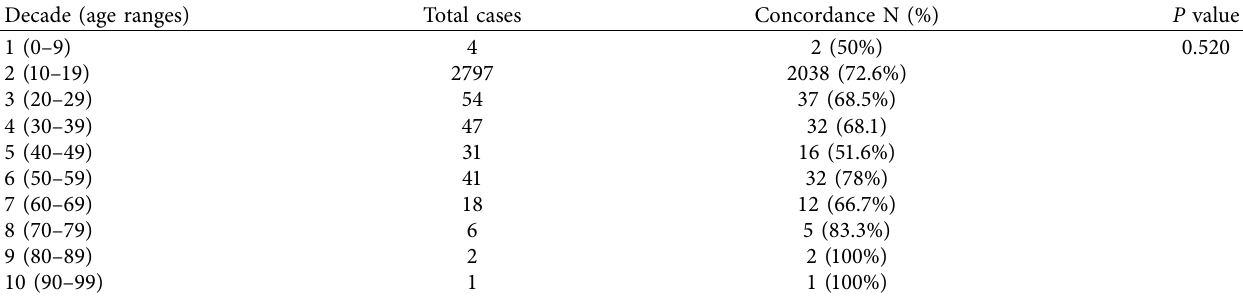
Table 1: Concordance rate of clinical and histopathologic diagnosis based on age ranges. Decade (age ranges)